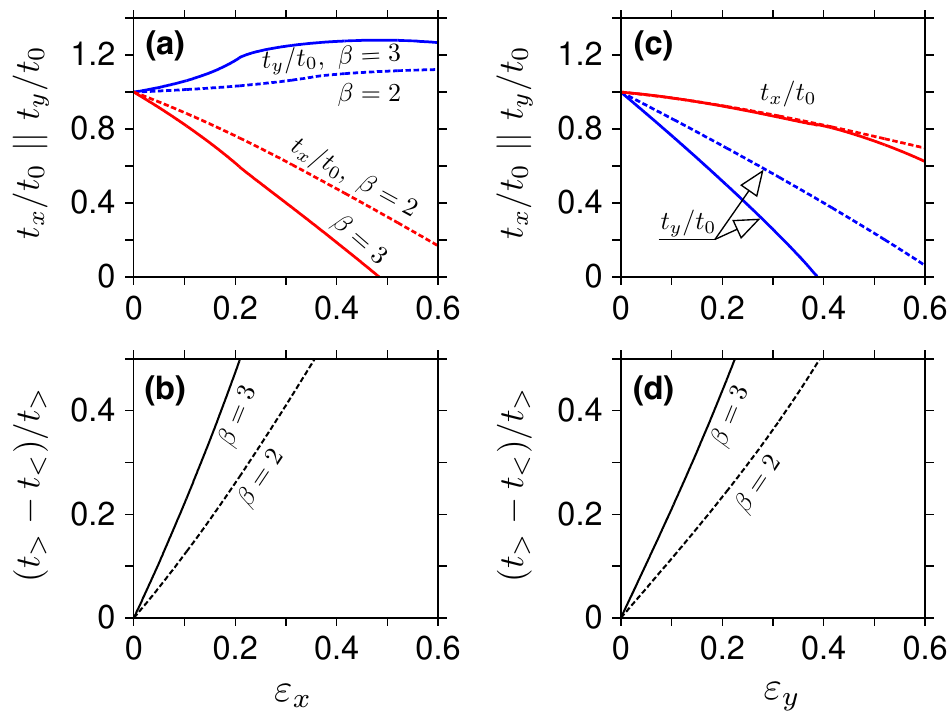
Figure A1. The hopping-matrix elements [see Equations (2) and (24) in the main text] as functions of the strain ε x > 0 ( a , b ) or ε y > 0 ( c , d ). The electron–phonon coupling is fixed at β = 2 (dashed lines in all plots) or β = 3 (solid